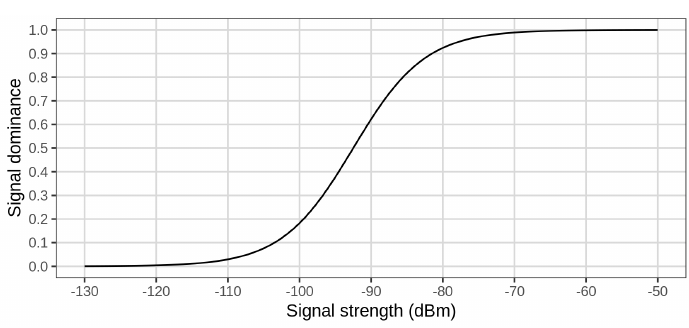
Figure 4: Logistic relation between signal strength ( dBm ) and signal dominance, where S S − 92 . 5 dBm and 0 . 2 dBm respectively to resemble Table steep are set to mid and